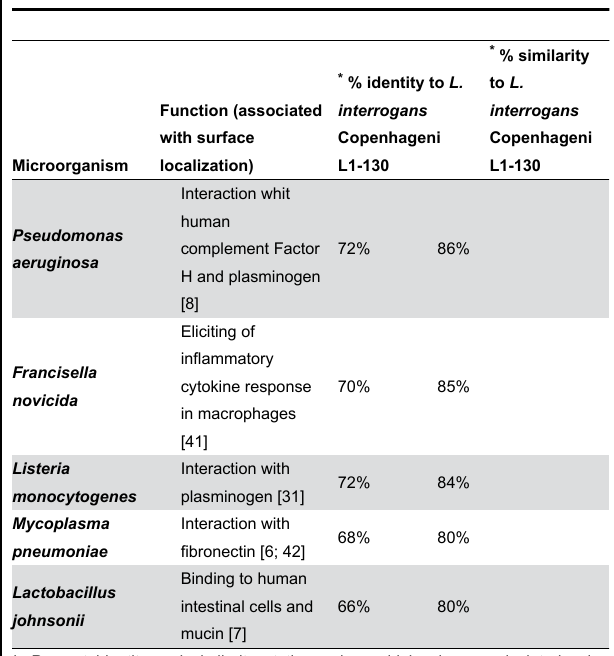
Table 1. Function of surface EF-Tu in different